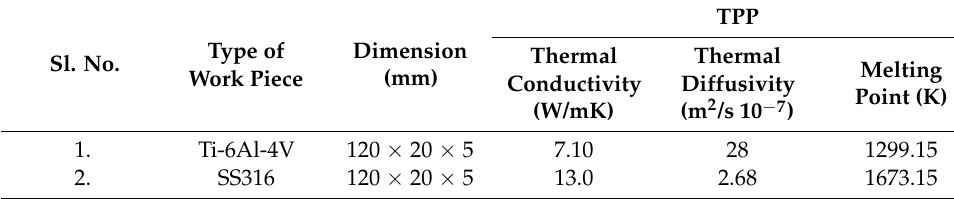
Table 2. Chemical composition of SS316.